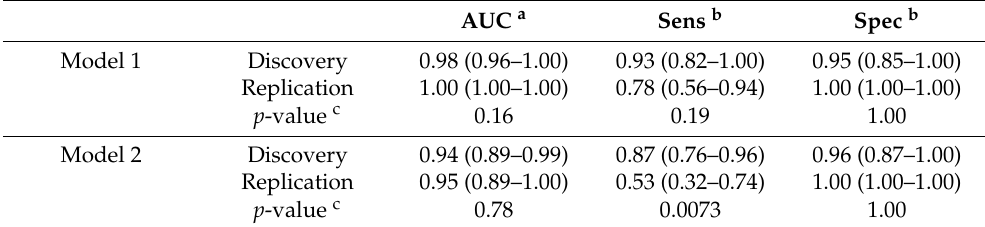
Table 3. Results from the multivariate modelling using all